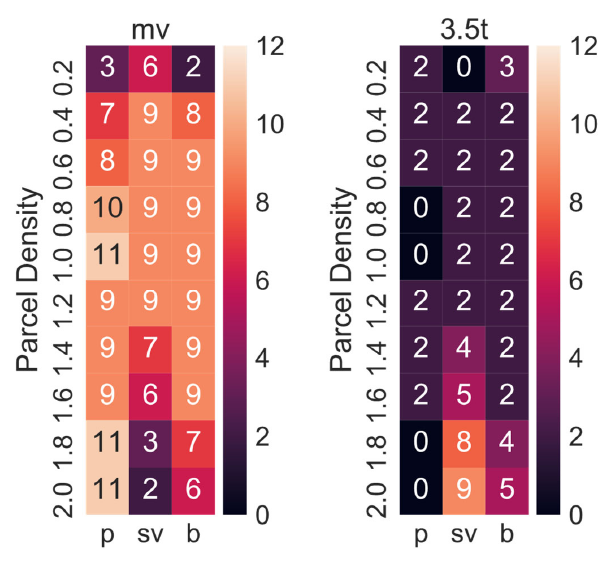
Figure 14. Numbers of times each maximum delivery van size (i.e. mv, 3.5 t) was the best option.